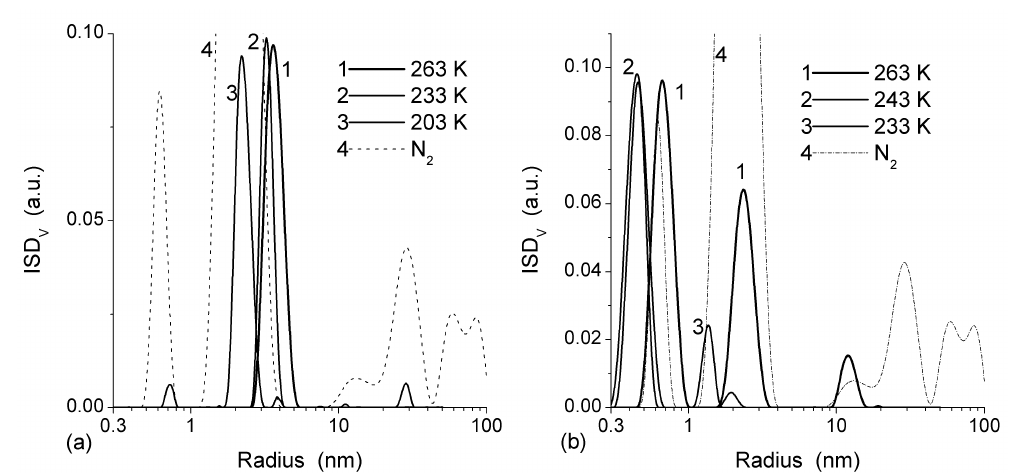
Fig. 6 Pore size distributions calculated on the basis of the nitrogen adsorption isotherm and ISDs based on CPMG echo decay envelopes for (a) benzene and (b) water adsorbed onto MCM-48 as a mixture with 200 mg C